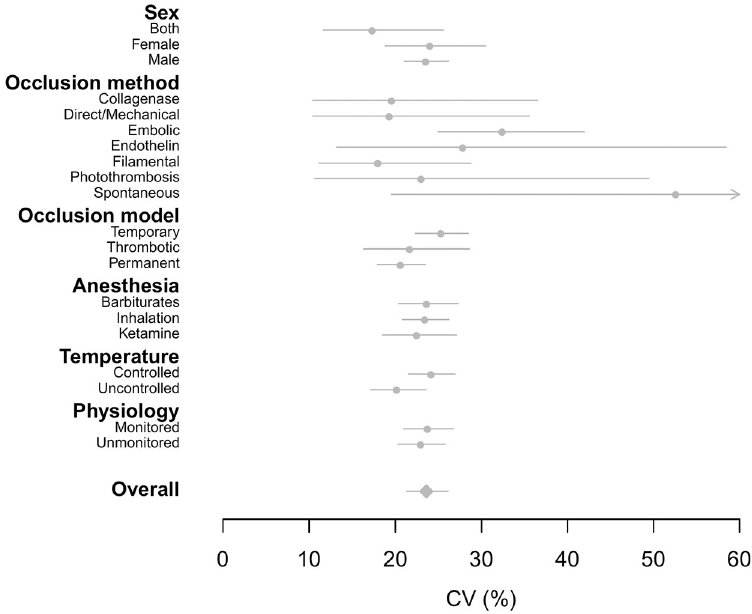
Fig 1. The effects of methodological parameters on variability (CV) in infarct volume across control groups. Mean estimates of unconditional (marginalized), group-specific coefficients of variation (%) are indicated as gray circles, while the overall estimate is indicated as a gray diamond. Moreover, 95% CIs are shown as gray lines and are asymmetric due to back-transformation of log coefficient of variation (lnCV) to the natural scale. Spontaneous occlusion generated the highest estimate of variability as indicated by the arrowhead. The overall and group-specific estimates were obtained from MLMA and MLMR models, respectively. The data underlying this figure can be found at https://doi.org/10.6084/m9.figshare.14527317.v4. CI, credible interval; C AU : AbbreviationlistshavebeencompiledforthoseusedthroughoutFigs 1 (cid:0) 3 andTable 1 : Pleaseverifythatallentriesarecorrect : V, coefficient of variation; lnCV, log coefficient of variation; MLMA, multilevel meta-analysis; MLMR, multilevel meta-regression.